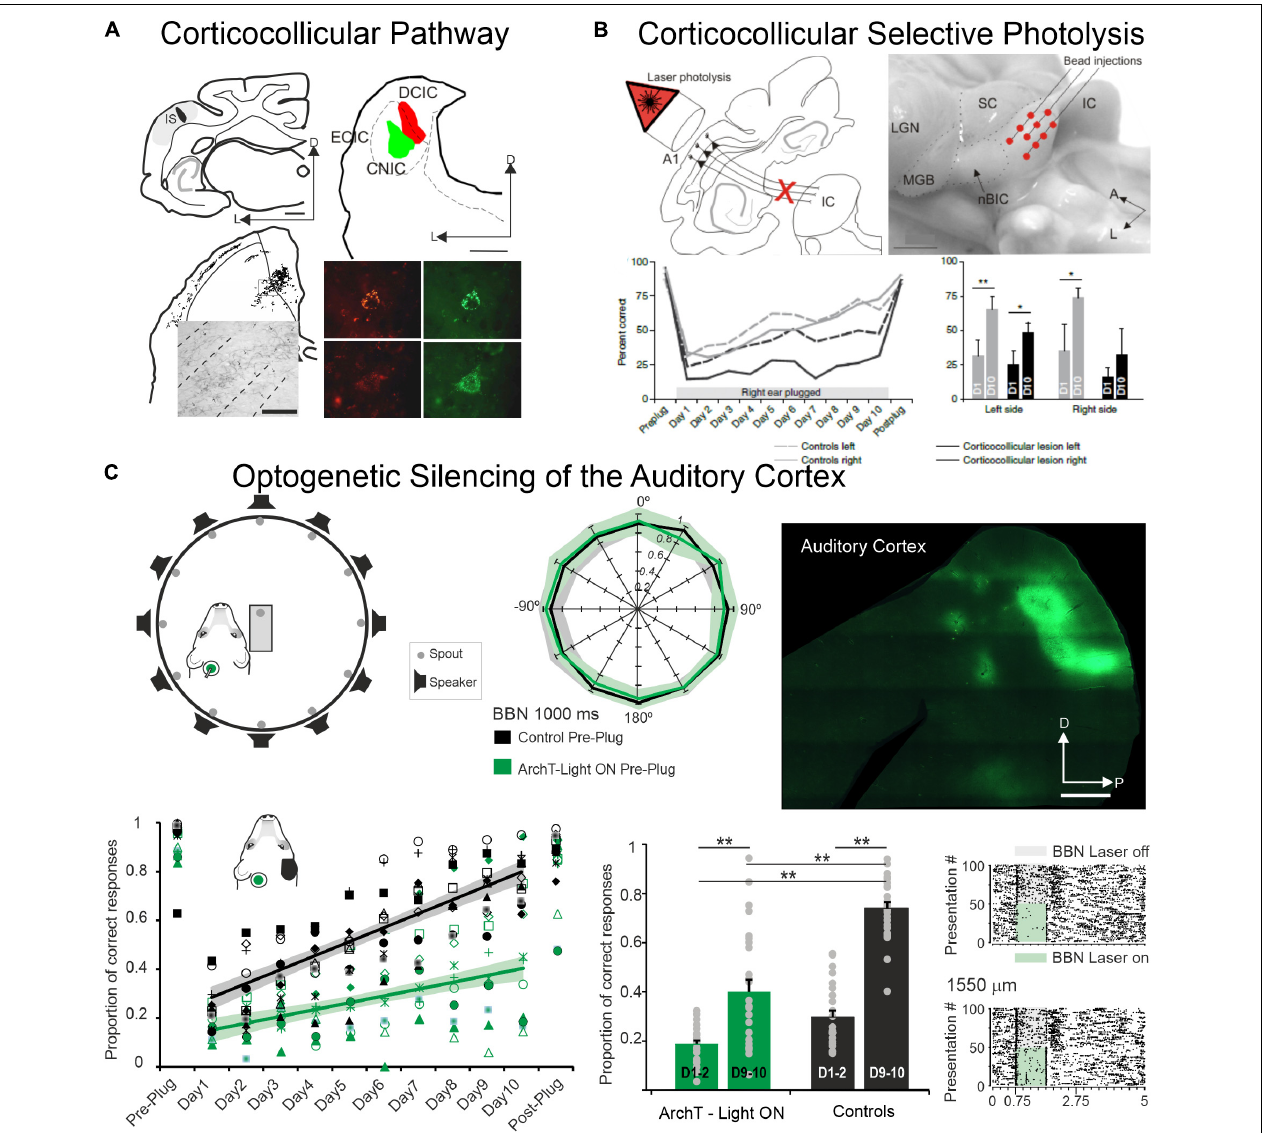
FIGURE 3 | The auditory cortex and the corticocollicular projection are essential for experience-dependent plasticity in spatial hearing. (A) Anterograde (top left) and retrograde (top right) tracer injections in the ferret the auditory cortex and in the Inferior Colliculus, respectively, reveal strong corticocollicular projection with terminal labeled fields in the three IC subdivisions (bottom left) after Fluororuby injection in A1 and retrogradely labeled cells in A1 (bottom right) after green and red fluorescent retrobead injections in the inferior colliculus. Modified from Bajo et al. (2007). (B) Chromophore-targeted laser photolysis of the corticocollicular pathway prevents learning-induced auditory plasticity. Corticocollicular layer V neurons were ablated using an infrared laser light (top left) following retrogradely neural labeling after microbead injections in the IC (top right) . Percent of correct responses in a sound localization task plotted against days of training including 10 days with unilateral right earplug (bottom left) . Data were grouped by left (dashed lines) and right (continuous lines) sound locations with control cases in gray and corticocollicular cases in black. In the bottom right, the mean and SD scores on the first (D1) and tenth day (D10) of monaural earplug are shown. Modified from Bajo et al. (2010). (C) Optogenetic silencing of the auditory cortex prevents earplug adaptation but not normal sound localization. Diagram shows the floor plan of the behavioral chamber (top left) and sound localization performance (proportion of correct responses at each speaker location). Data from control cases are in black and cases where neural activity in left A1 was optogenetic silenced using ArchT expression and green light illumination during each stimulus presentation in green (middle panel) . Histological section of a flattened auditory cortex showing GFP immunofluorescence associated with ArchT expression (top right) . Proportion of correct scores averaged across all speaker locations achieved by each animal in the control and A1 silenced groups (preplug session, 10 days with right earplug, and postplug) (bottom left) . Proportion of correct responses for the first and last 2 days of monaural occlusion (middle panel) . Examples of neural optogenetic suppression in A1 are shown in the bottom right panel. Neural responses driven by broadband stimulation [gray rectangles or combined with laser illumination (green rectangles)]. Modified from Bajo et al. (2019). * P < 0.05, ** P < 0.01. Scale bars = 1 mm in (A,C) , 2 mm in (B) . A, anterior; A1, primary auditory cortex; BBN, broadband noise; CNIC, central nucleus of the inferior colliculus; D, dorsal; DCIC, dorsal cortex of the inferior colliculus; ECIC, external cortex of the inferior colliculus; HP, hippocampus; IC, inferior colliculus; IS, injection site; L, lateral; LGN, lateral geniculate nucleus; MGB, medial geniculate body; nBIC, nucleus of the brachium of the inferior colliculus; P, posterior; SC, superior